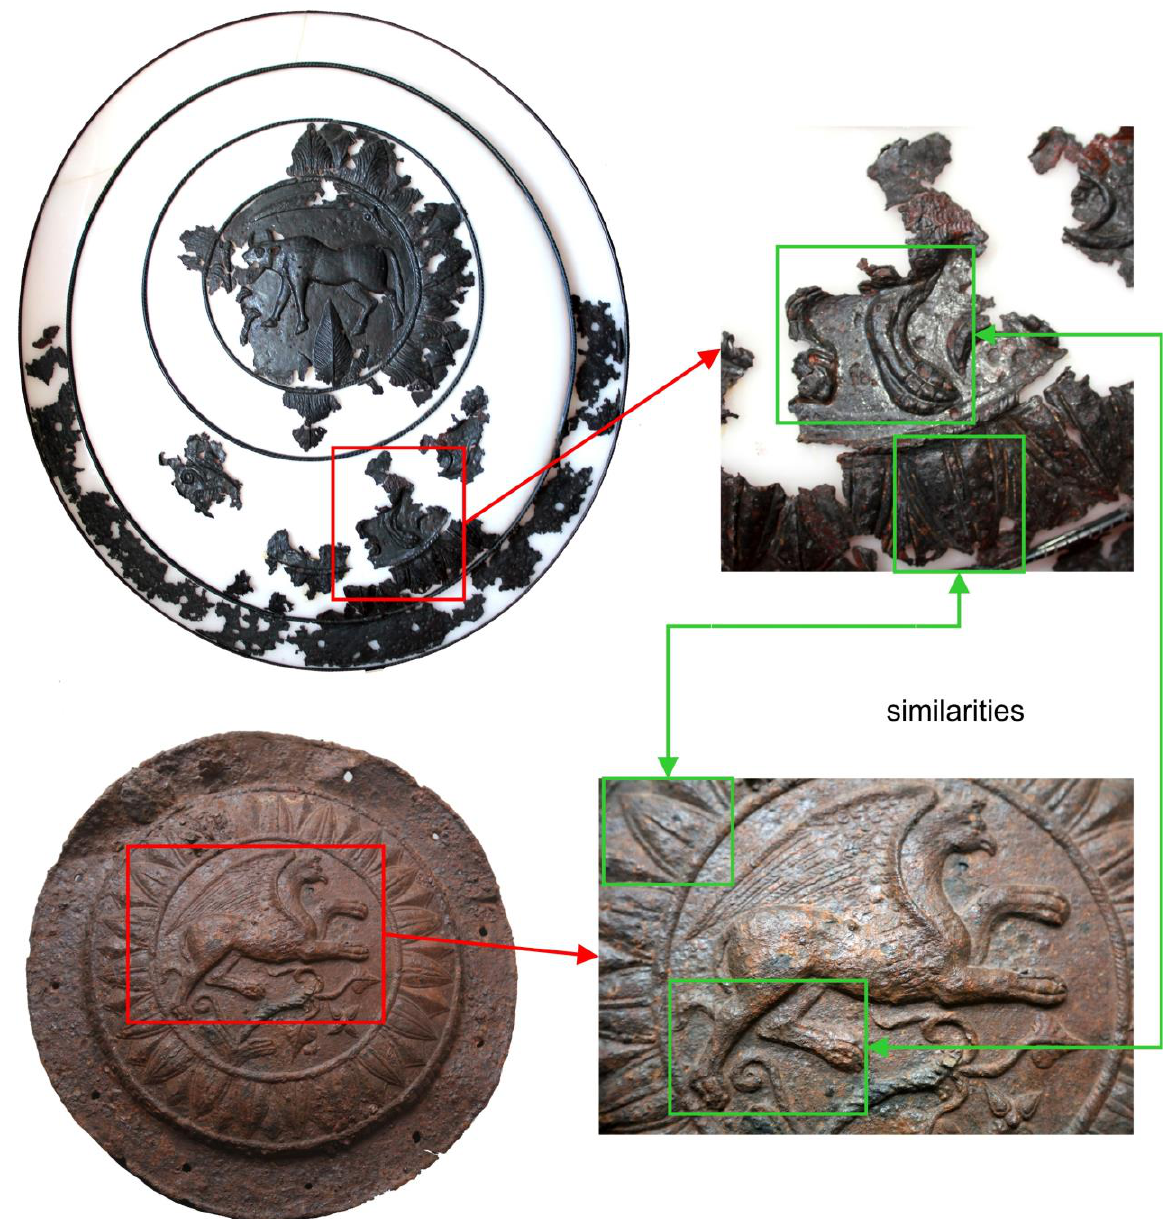
Figure 12. Similarities between the griffin fragment and the griffin embossed disk repatriated in 2011.